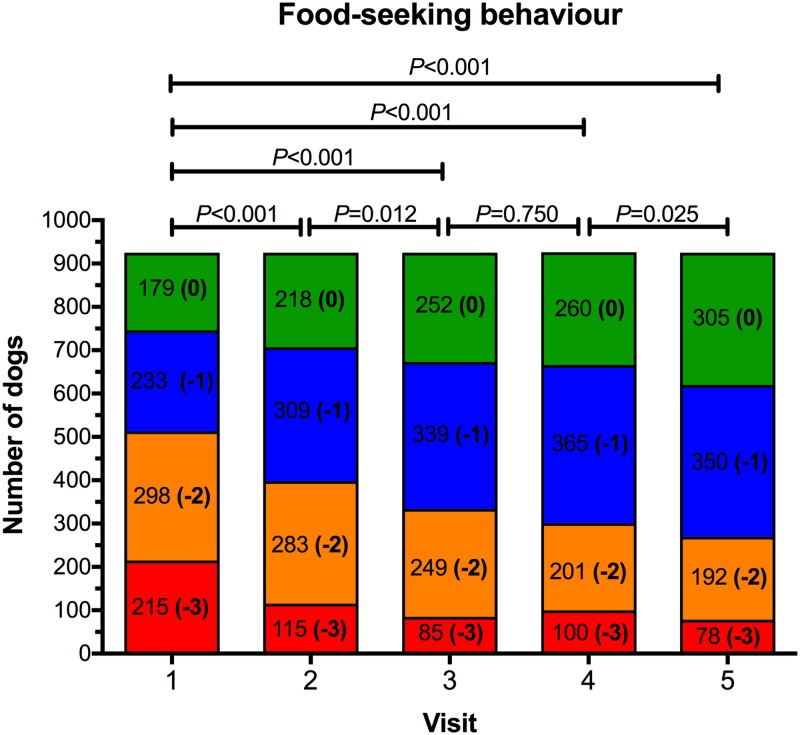
Food-seeking behaviour scores for dogs during the study.Food seeking behaviour was subjectively determined at each visit after a discussion between the veterinarian and owner (Table 3). At each visit, blocks with different colours represent the proportion of dogs assigned a food-seeking behaviour score of -3 (red), -2 (orange), -1 (blue) and 0 (green), respectively. The number of dogs assigned to each category is also shown.